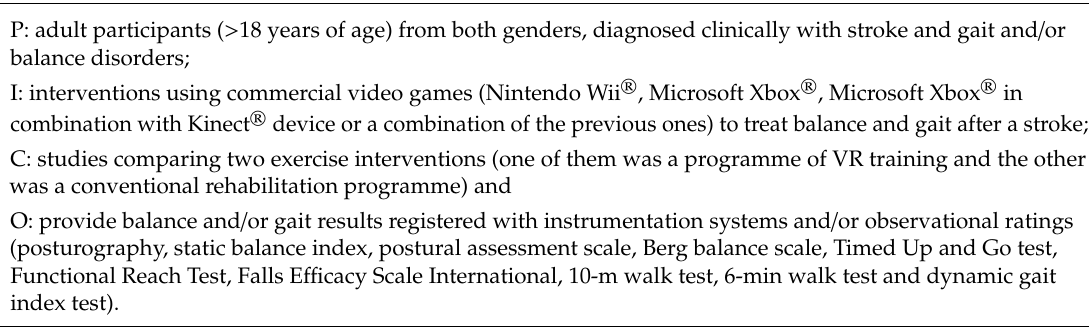
Table 2. Eligibility criteria according to Population, Intervention, Comparation and Outcome (PICO). P: adult participants ( > 18 years of age) from both genders, diagnosed clinically with stroke and gait and / or balance